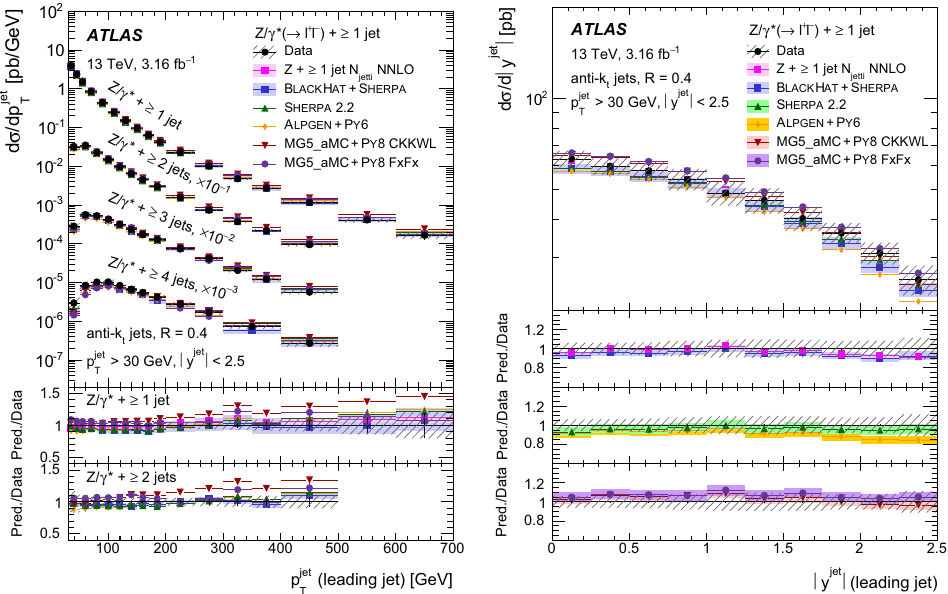
tematic uncertainties (including luminosity) added in quadrature. The details of the prediction uncertainties are given in the text. For clar- ity, uncertainty bands are not shown for the Monte Carlo predictions in the left-hand plot . Uncertainties from the QCD scale variations for the Z + ≥ 1 jet N jetti NNLO predictions are included, as described in Sect. 3.3